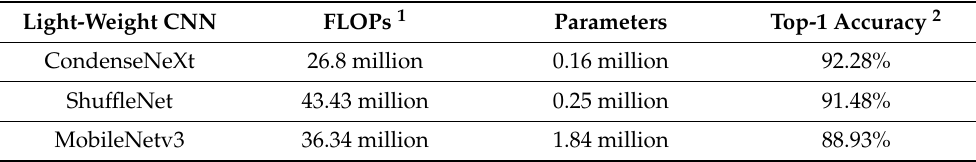
Table 4. Comparison of light-weighted CNN backbone performance with a scaling factor of 0.5 on CIFAR-10 dataset.